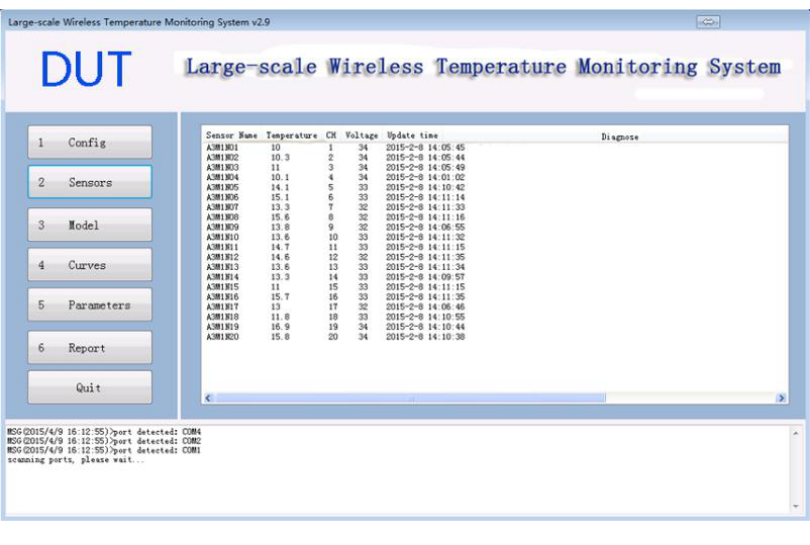
Figure 13. Sensors Module.